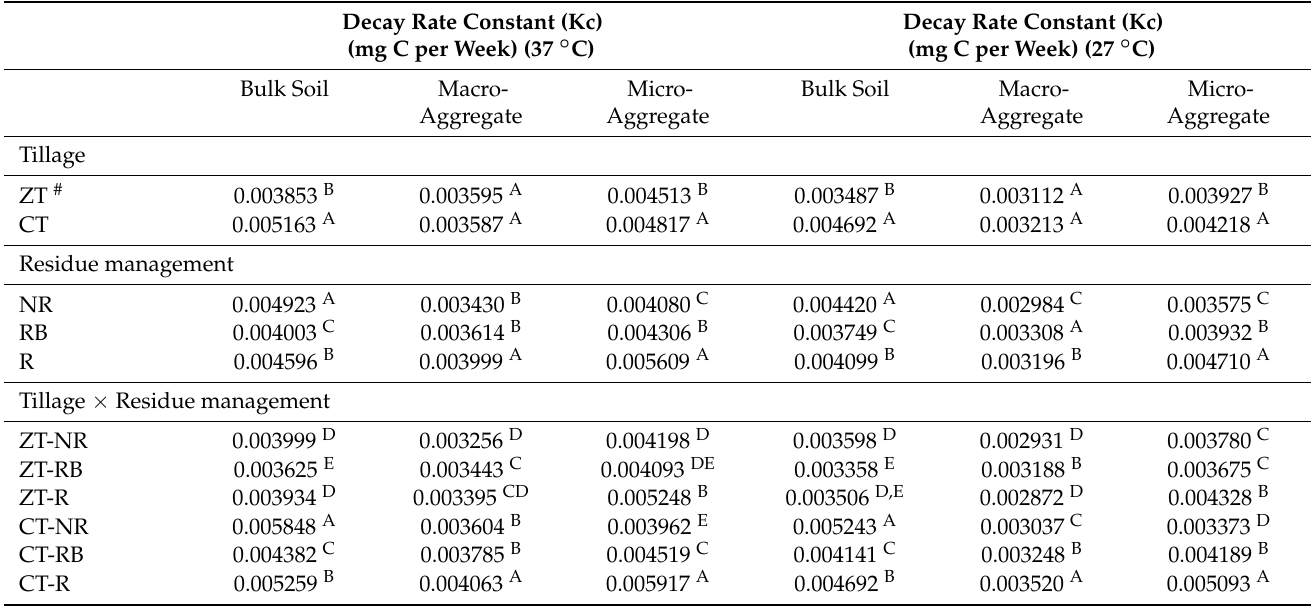
Table 3. Decay rate constant (Kc) of SOC mineralization in bulk and aggregate soils of 0–5 cm as influenced by 18 years of tillage and residue management under a rice–wheat cropping system in an Inceptisol.